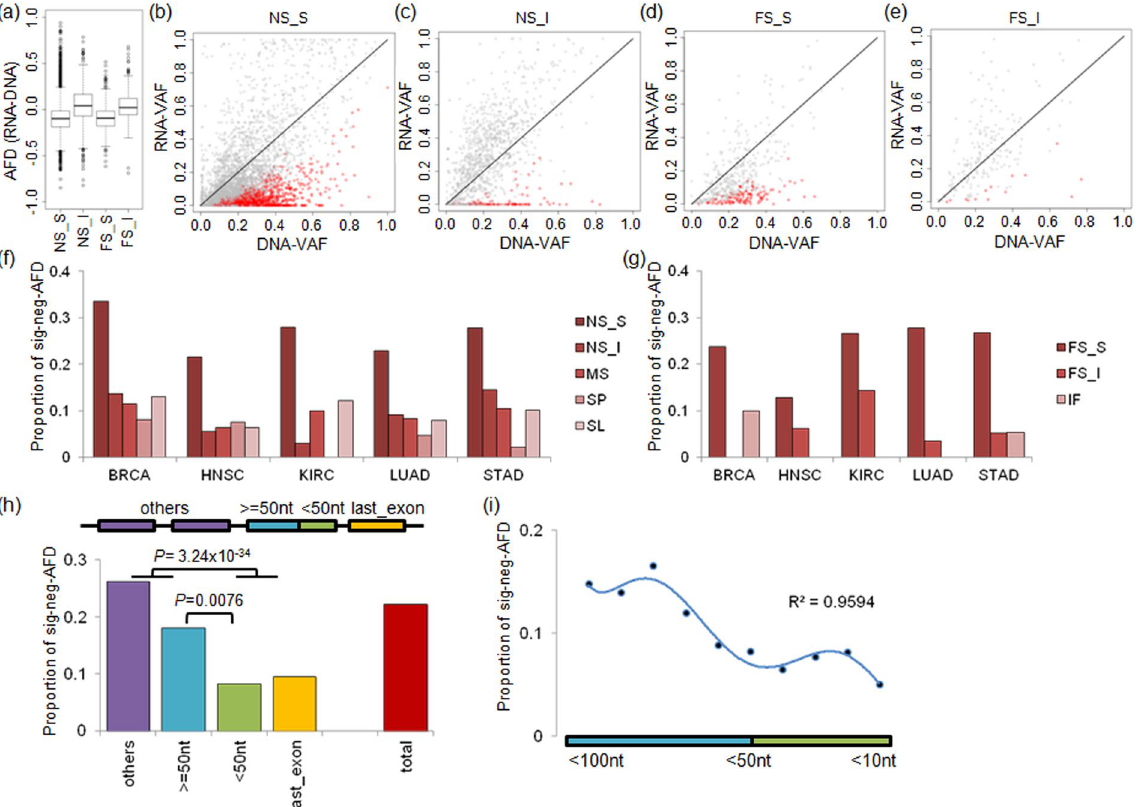
Figure 2. NMD and the 50-nt rule. ( a ) The boxplot shows AFD of NMD-sensitive and -insensitive variants. The NMD-sensitive and -insensitive variants are classified according to the 50-nt rule. NS_S, NMD-sensitive nonsense mutations; NS_I, NMD-insensitive nonsense mutations; FS_S, NMD-sensitive frameshift indels; FS_I, NMD-insensitive frameshift indels. ( b–e ) Scatterplots show the DNA-VAF and RNA-VAF observed in NS_S ( b ), NS_I ( d ), FS_S ( e ), FS_I ( f ). Red indicates sig-neg-AFD mutations. ( f ) Barplots are shown for the sig-neg- AFD ratio of SNVs in individual tumor types. The sig-neg-AFD ratio was calculated as the number of sig-neg- AFD mutations divided by the total number of the somatic mutations in each tumor type. ( g ) Similarly shown for indels. ( h ) The sig-neg-AFD ratios shown for the last exonic region (yellow), >= 50 nt and < 50 nt in the penultimate exon (blue and green, respectively) and the other exonic regions (purple). The sig-neg-AFD ratio for all the exonic region is shown at the rightmost bar (red). ( i ) The sig-neg-AFDs ratios are shown with respect to the distance of PTC from the last exon-exon junction at the penultimate exon. The x -axis is represented as a cumulative scale, that is < 10 nt is 0 to 10 nt, < 50 nt was 0 to 50 nt, and < 100 nt is 0 to 100 nt. The point is marked on every 10 nts.